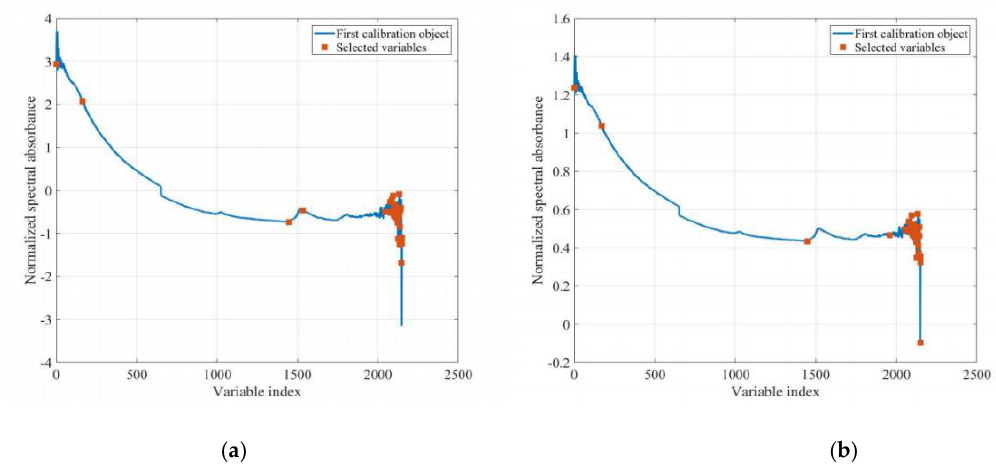
Figure 5. Wavelength extraction results of SOM content VIS-NIRS based on SPA. ( a ) Characteristic wavelengths distribution of S-G-SNV pretreated spectra extracted by SPA and ( b ) characteristic wavelength distributions of S-G-MSC pretreated spectra extracted by SPA.